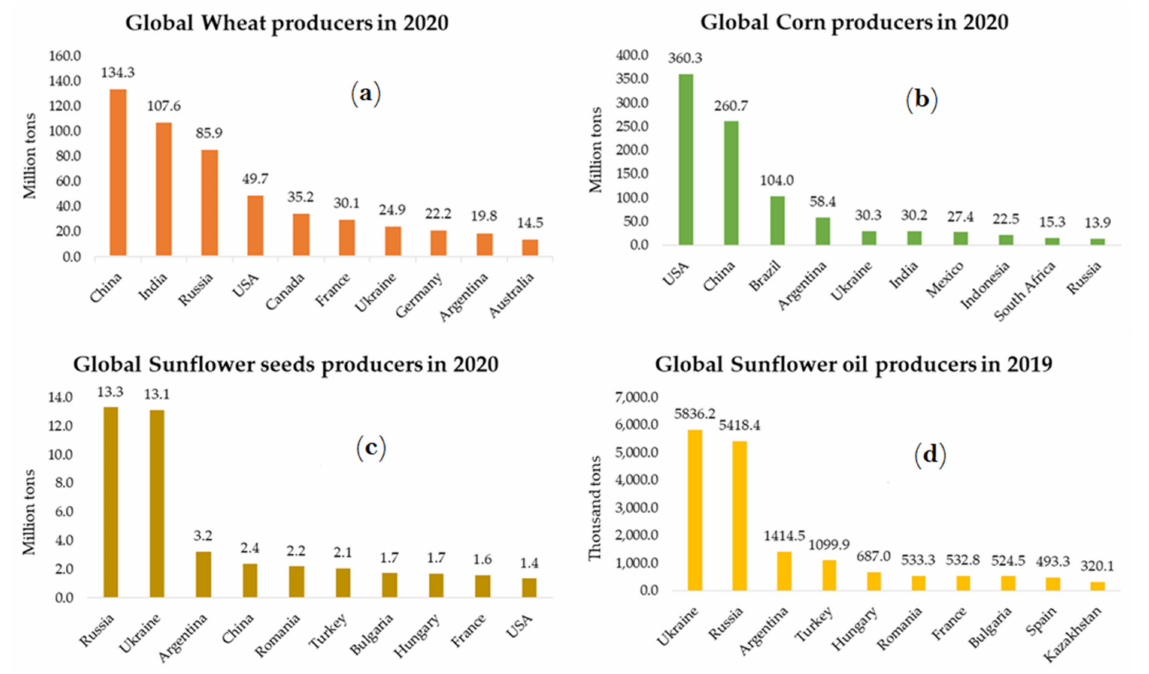
Figure 5. Global producers of wheat ( a ), maize ( b ), sunflower seed ( c ) in 2020, and sunflower oil ( d ) in 2019. Data adapted from FAOSTAT